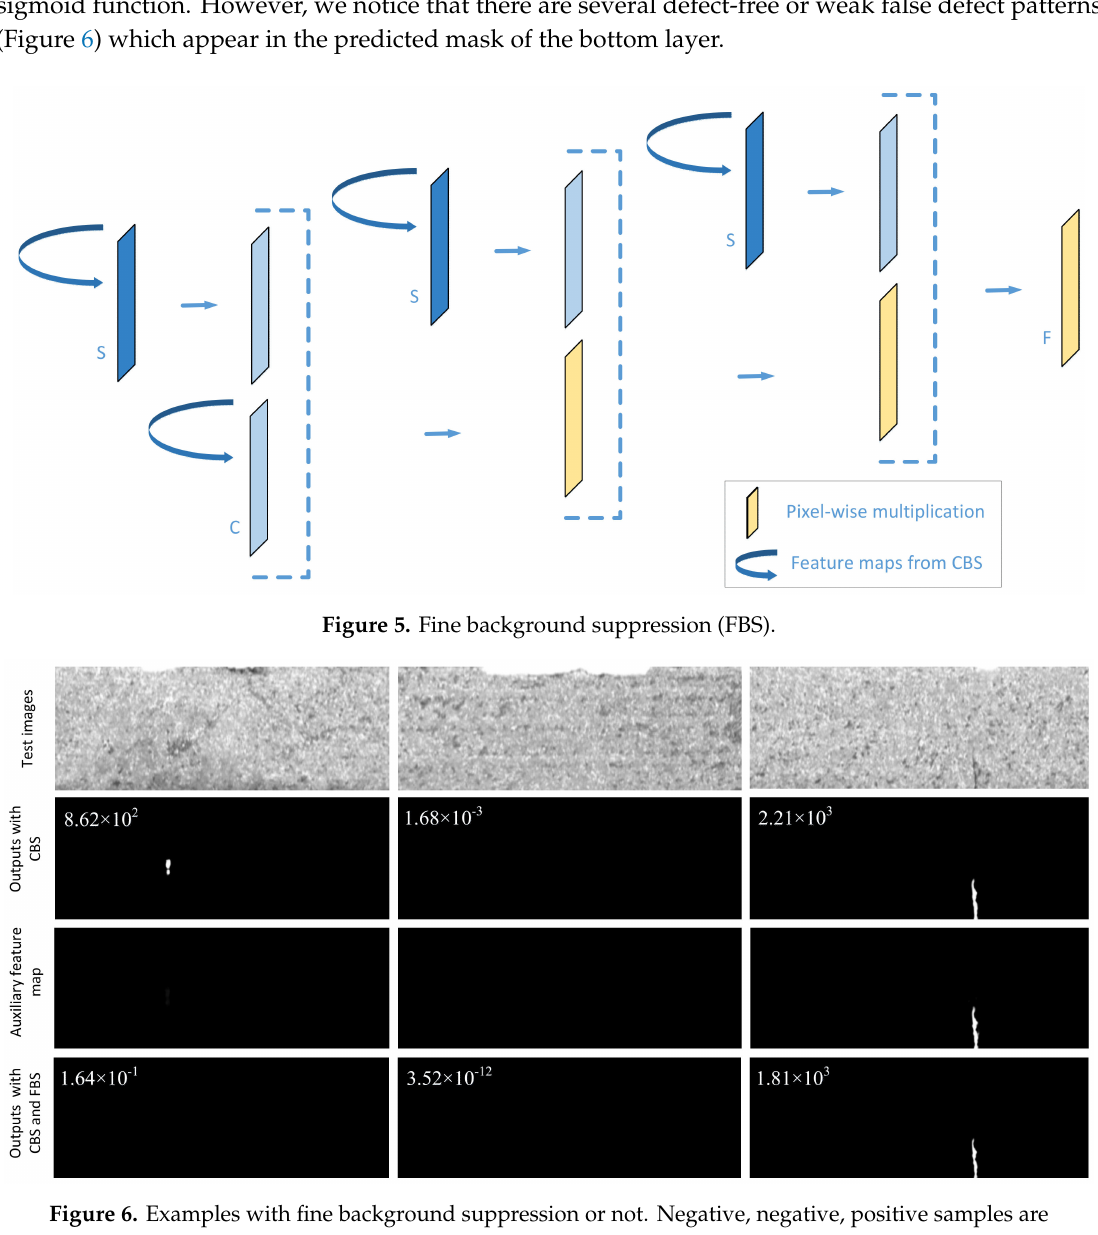
Figure 6. Examples with fine background suppression or not. Negative, negative, positive samples are shown respectively in row 1, where the first image in row 1 represents a few new prediction results with obvious false alarms via coarse background suppression, while the images in row 3 indicate auxiliary feature maps from bottom layers, and the figures in the top left corners denote the scores via our classification